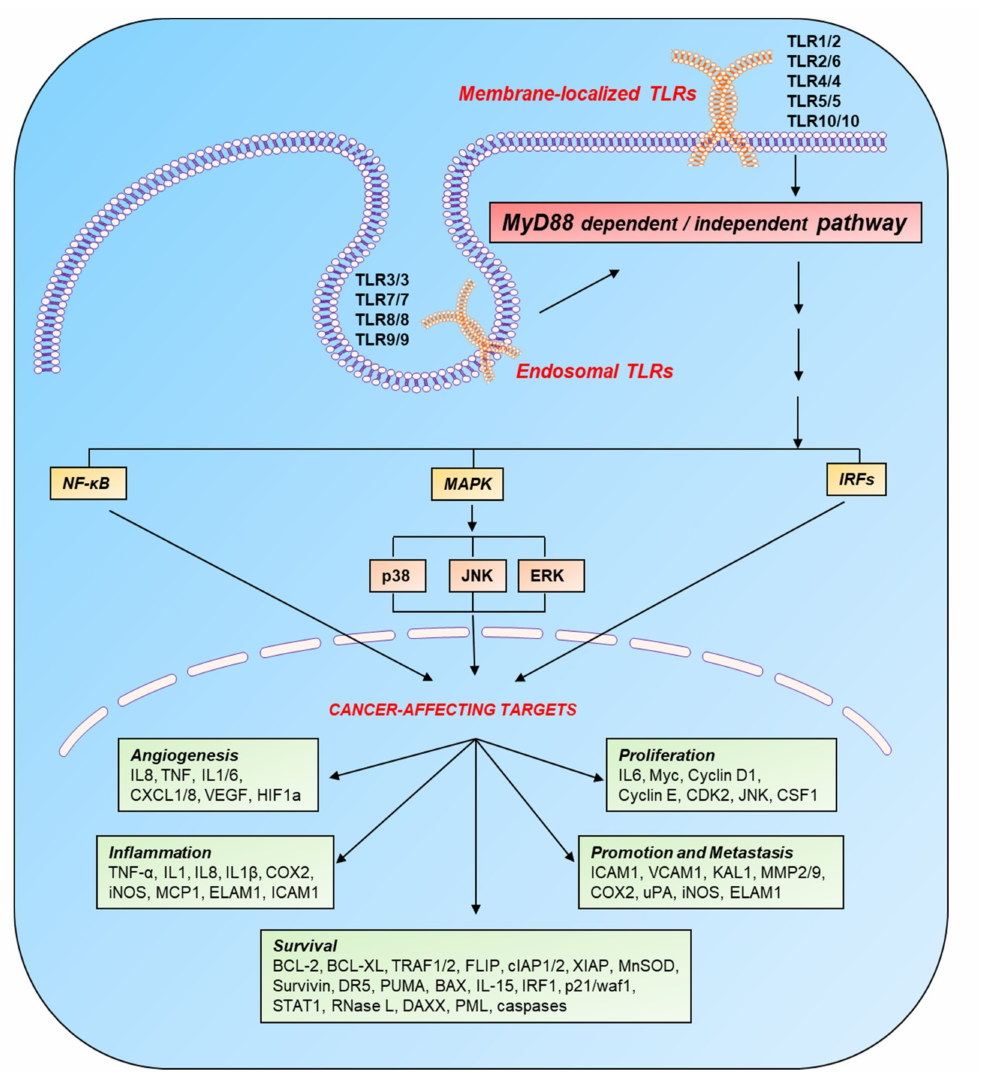
Figure 1. Induction of cancer-a ff ecting genes by TLR signaling. TLRs are localized on the cell surface and in the endosomal compartment and become active after recognizing their respective PAMPS and